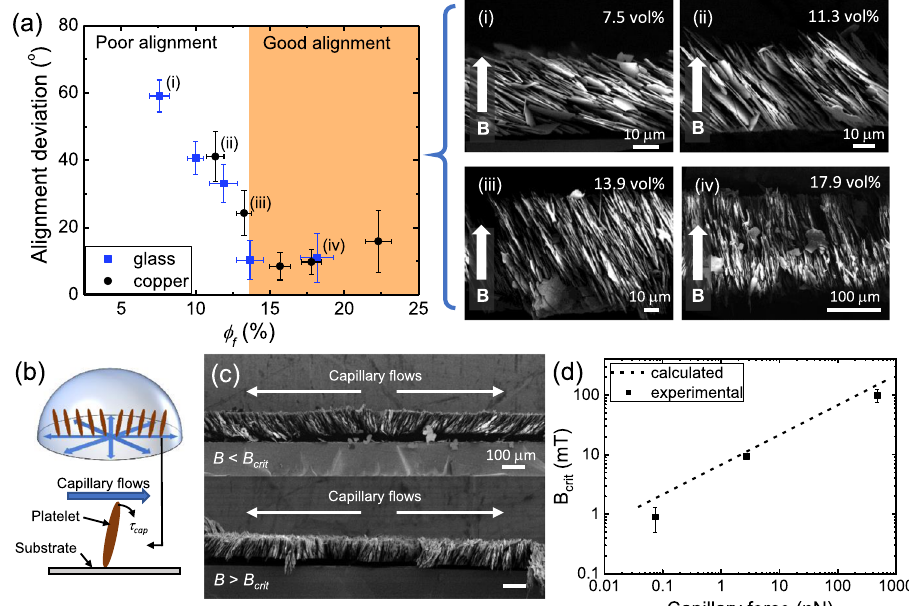
Fig. 3 | Optimal conditions for effective magnetic alignment demonstrated with the xirallic ink. a Variation of the microplatelet alignment deviation with respect to the target 90° angle in the dried droplet deposited on glass (blue) and copper (black) substrates as a function of the fi nal platelet concentration ϕ f . The shaded area shows the region where the platelets are aligned according to the target90°angle.(i),(ii),(iii)and(iv)refertotheimagesontherightwhicharecross- sectional electron micrographs of the droplets at ϕ f =7.5, 11.3, 13.9 and 17.9vol%, respectively. b Schematics of the capillary fl ows generated within a drying sessile